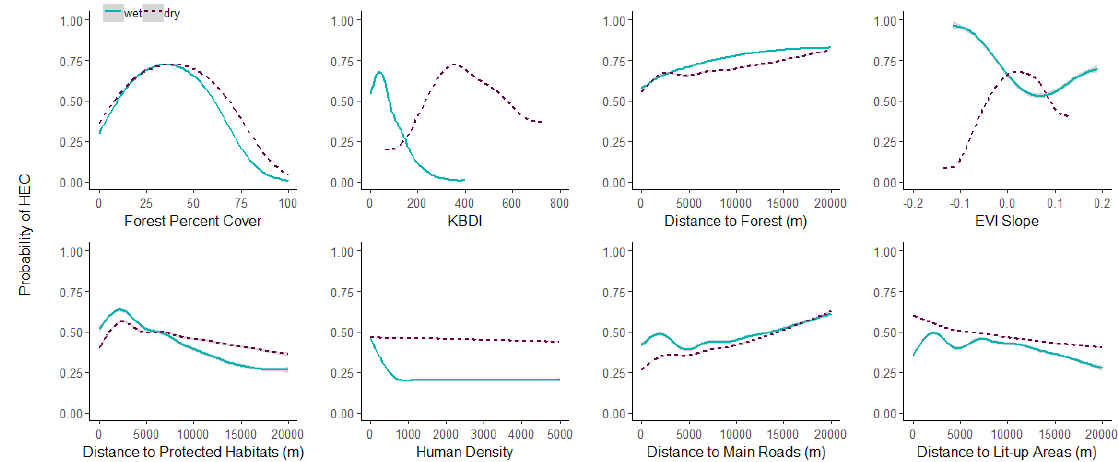
Figure 3. Relative probability of human–elephant conflict (HEC) occurrences for each environmental predictor, grouped based on resource suitability ( top ) and direct human pressure ( bottom ), while keeping all other predictors at average values. The predictors shown had a combined contribution greater than 80%. KBDI, Keetch–Byram Drought Index. EVI, Enhanced Vegetation